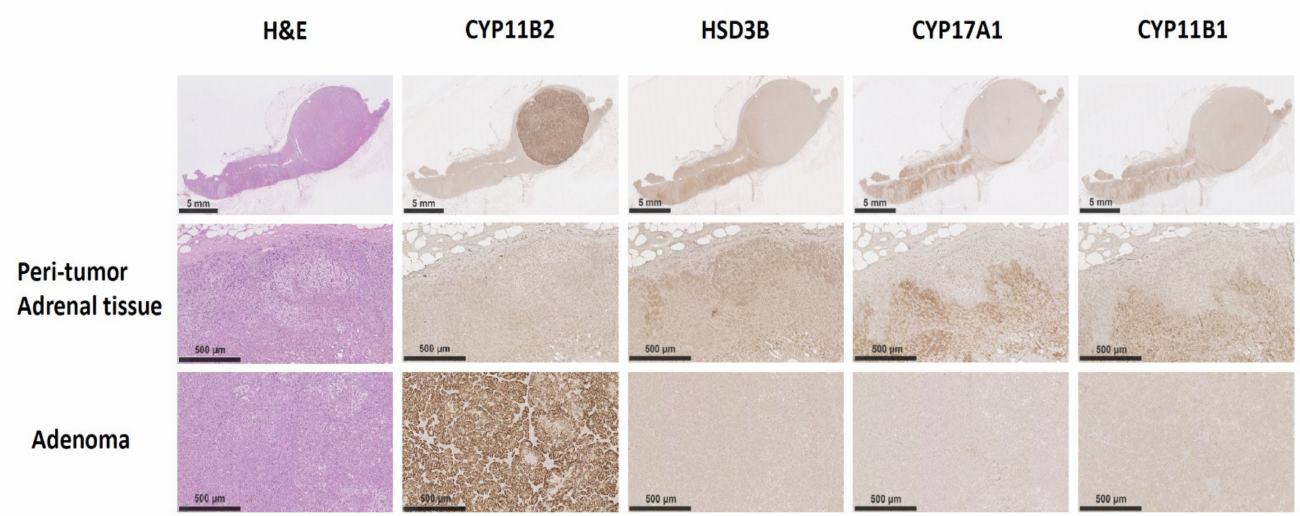
Figure 1. A novel ATP2B3 K416-F418delinsN mutation in classical APA. ( A ) The deletion at nucleotide 1248 to 1253 as GTTCTT in the ATP2B3 K416-F418delinsN gene was identified in a patient with APA in the resected adrenal adenoma. The amino acid residue 416 to 418 of ATP2B3 protein was substituted from lysine (Lys) and 2 phenylalanine (Phe) to asparagine (Asn) insertion. The letters for nucleotide bases represented as following: C, cytosine; G, guanine; T, thymine; ( B ) the protein secondary structure of mutant ATP2B3 channel was demonstrated. The yellow circle N represented insertion of amino acid, asparagine. The model was based on Protter software application [31] (http://wlab.ethz.ch/protter/start/ (accessed on 22 July 2021) [32]).